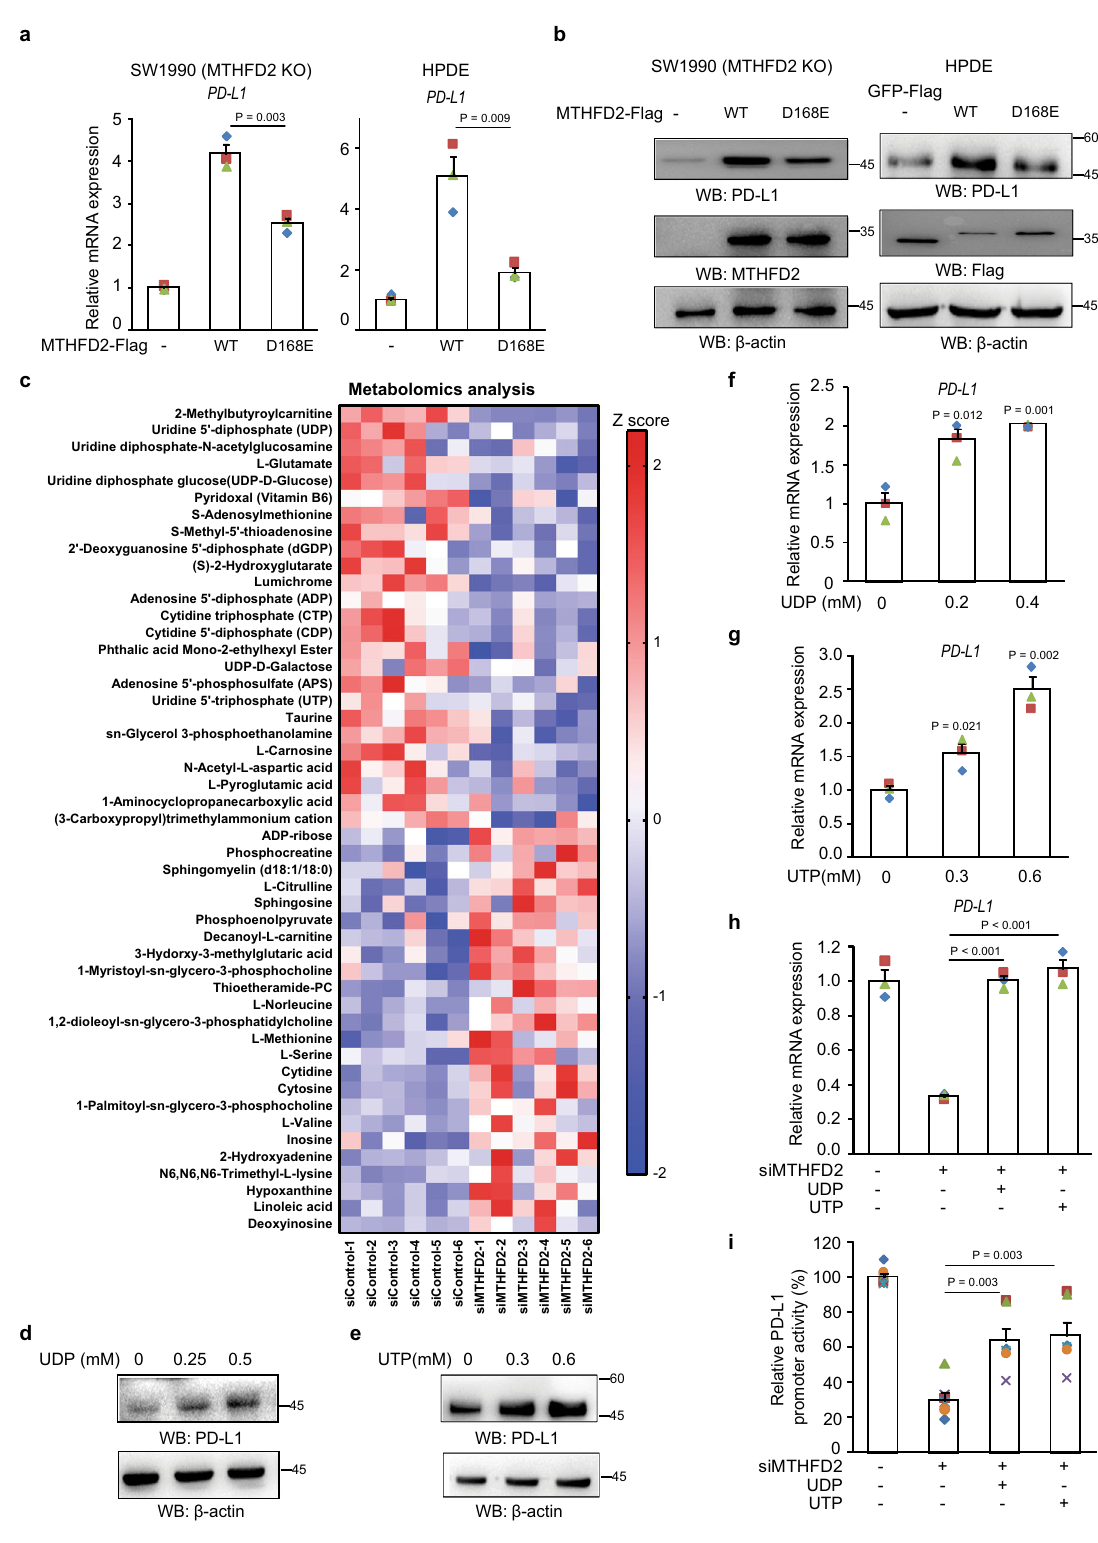
Sphingomyelin (d18:1/18:0)